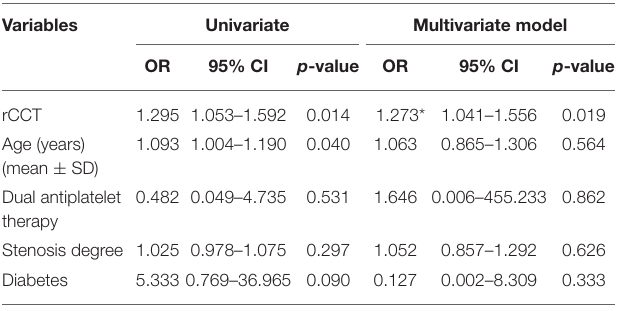
TABLE 2 | Multivariable logistic regression analysis to evaluate the association between DICE and risk factors, including rCCT. Variables Univariate